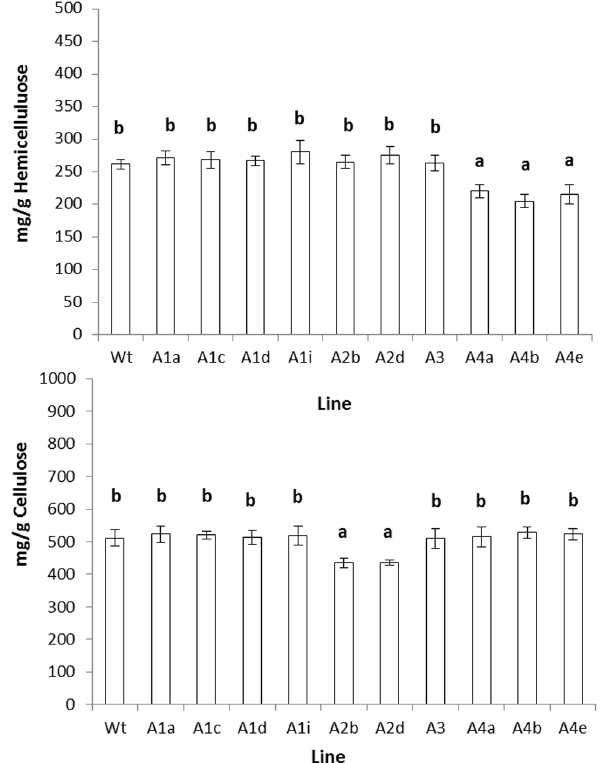
Figure 1. Principal component analysis (PCA) of FT-IR spectra of Arabidopsis stem material. Powdered stem tissue from wild type and rabA sub clade mutant lines of Arabidopsis were subjected to analysis using FT-IR. The spectral data in the region of1200 nm–800 nm was used to generate the PCA. The total number of principle components identified was 5, PC1=0.59 PC2=0.39, with the remaining components each totalling less than 0.1 of the variation.